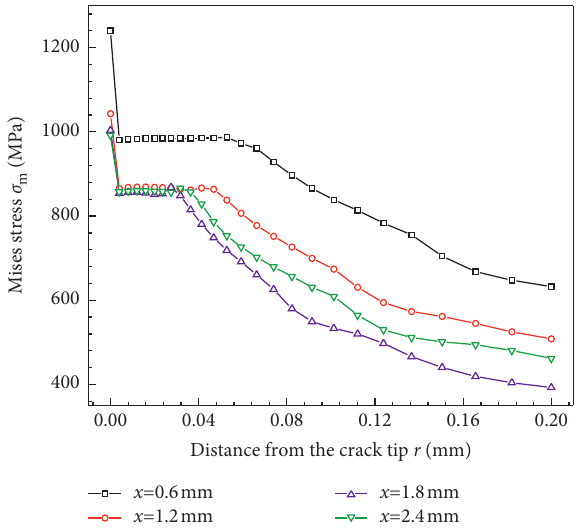
Figure 12: Mises stress curves at the front of initiation crack